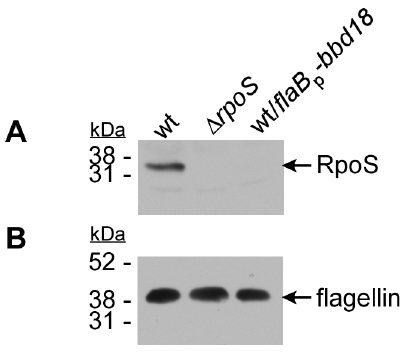
Figure 4. Synthesis of RpoS by wild type but not bbd18 - expressing B.burgdorferi Immunoblot analysis of cell lysates from strains B31-S9 (wt), B31-S9 D rpoS ( D rpoS ) and B31-S9/pBSV2*- flaB p- bbd18 (wt/ flaB p- bbd18 ) grown under rpoS- inducing conditions. Cell lysates were analyzed using RpoS antiserum (A) or a mouse monoclonal antibody to flagellin (B) to assess flagellin levels as a protein loading control. Cell lysates and immunoblot for flagellin were the same as those used in Fig. 1. Positions of molecular mass standards are shown on the left in kiloDaltons (kDa).